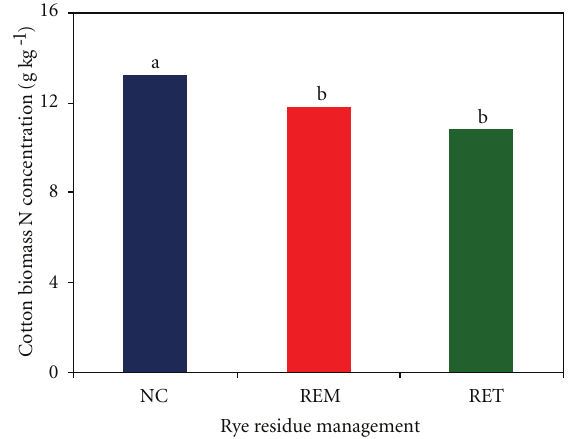
Figure 6: E ff ect of rye residue management on cotton biomass N concentration between first square and cutout, averaged across years and N rates. Columns sharing the same letter are not significa- ntly di ff erent ( P ≤ 0 . 05). NC: no winter cover crop; REM: rye residue removed; RET: rye residue